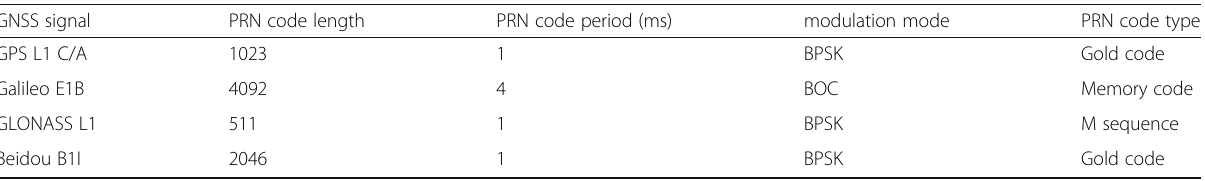
The table shows the difference between the four constellations in terms of the code length, the code rate, the mode of modulation, and the way of code generation of the